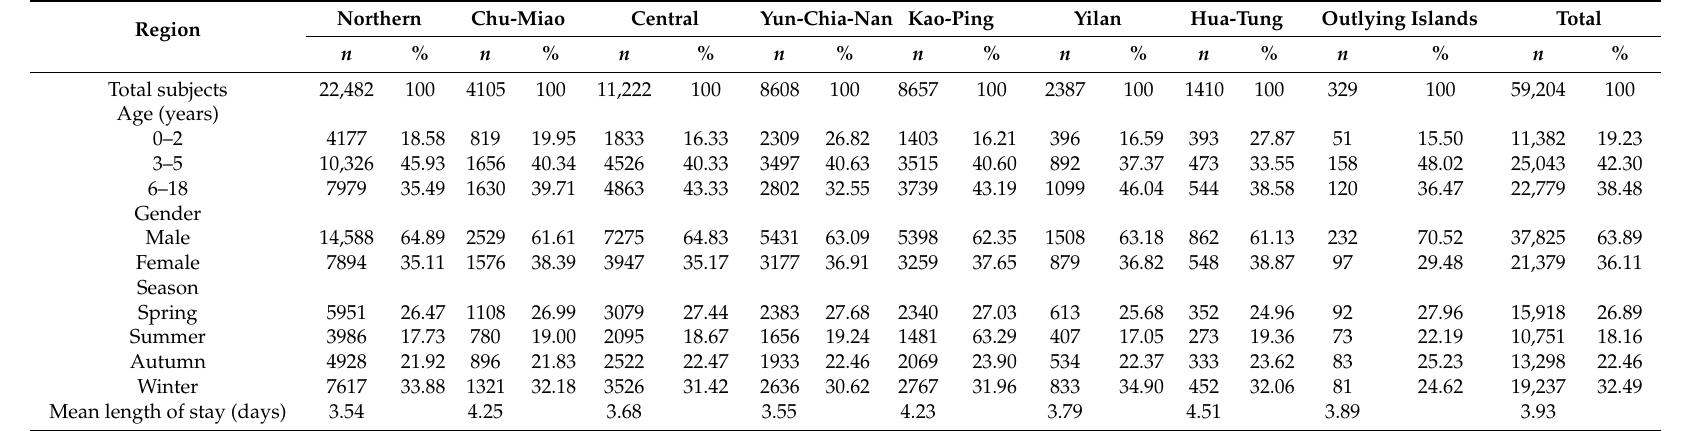
Table 1. Characteristics of asthma hospitalization in different regions in Taiwan,